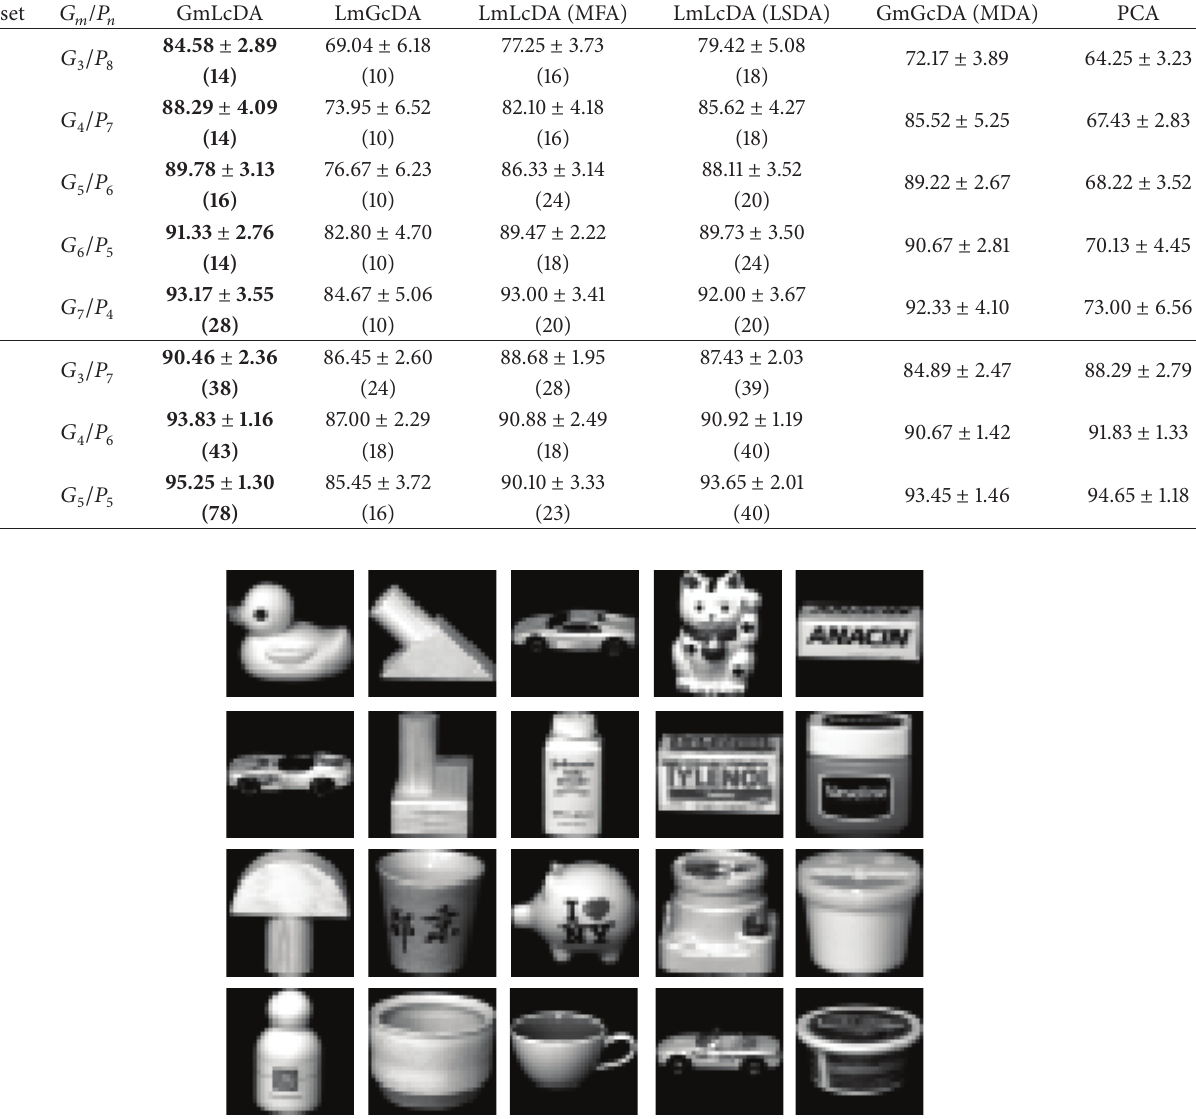
Figure 4: Sample images of 20 objects from